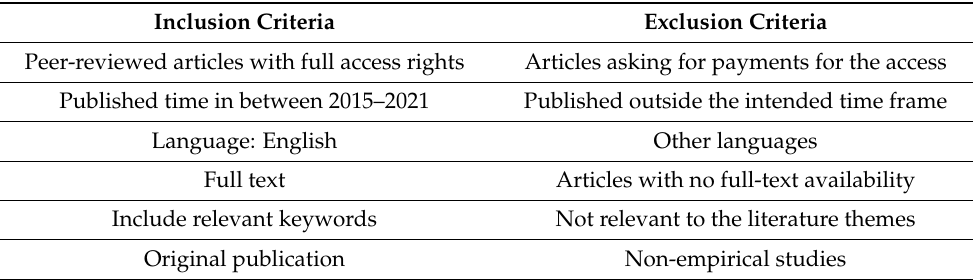
Figure 1. PRISMA flow chart. Table 2. The PRISMA statement’s inclusion and exclusion criteria.